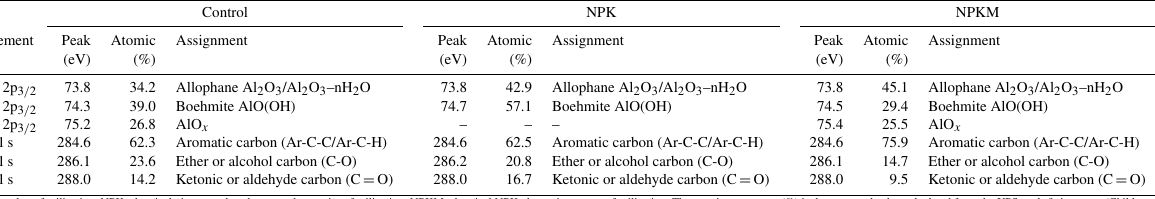
Table 2. Binding energy and quantitation/assignment of XPS spectral bands of soil samples from three separate long-term (1990–2014) fertilization treatments a .